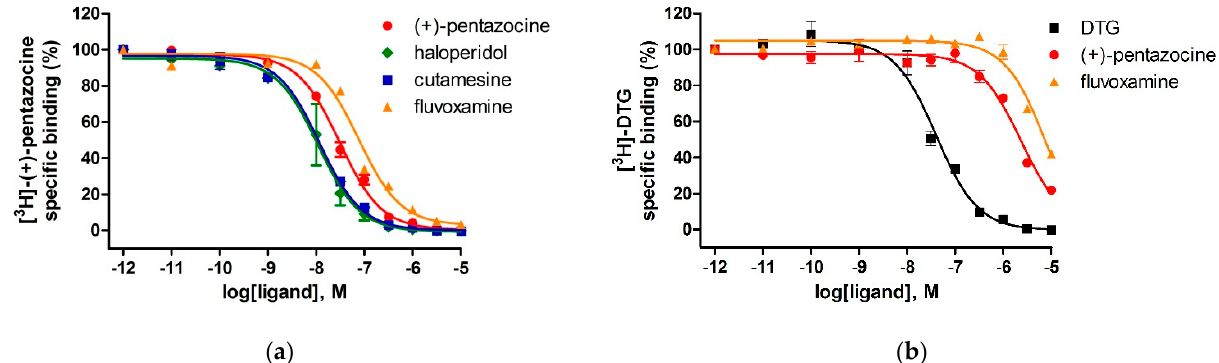
Figure 3. Displacement curves for reference compounds against ( a ) [ 3 H]-(+)-pentazocine binding to S1R in guinea pig liver and ( b ) [ 3 H]-DTG binding to S2R sites in rat liver membranes. Data are mean percentage of specific binding ± SEM from minimum three independent experiments, each performed in duplicate. Table 2. Sigma-1 and sigma-2 receptor binding affinity (K i ) and S2R/S1R selectivity for known sigma receptor